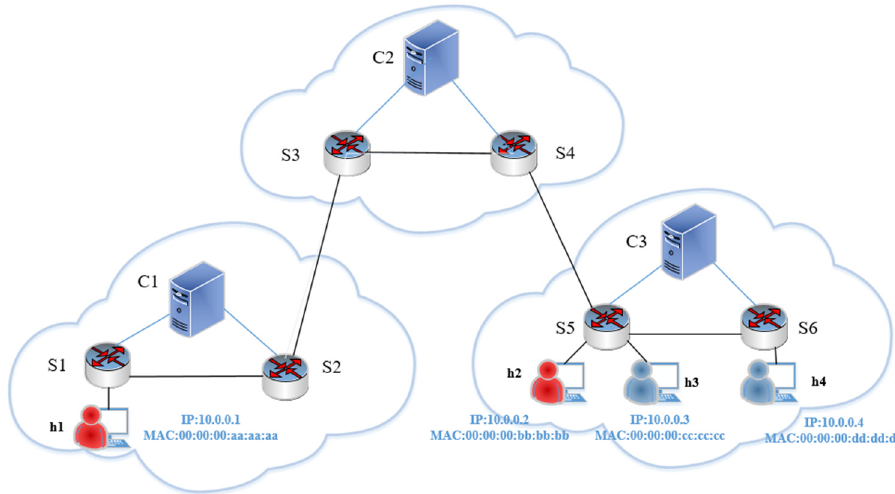
Figure 5. Network topological diagram.